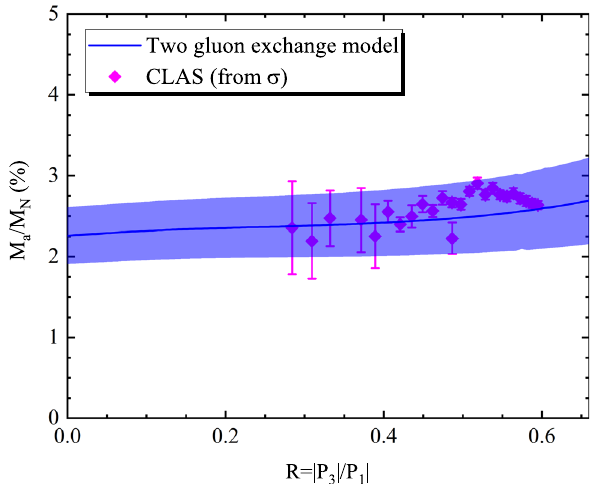
Fig. 3 The trend of the trace anomaly contribution with R based on total cross section of φ predicted by the two gluon exchange model (the blue line). The magenta diamond is extracted from the CLAS data [24]. Here, the blue band is the error bar of A 0